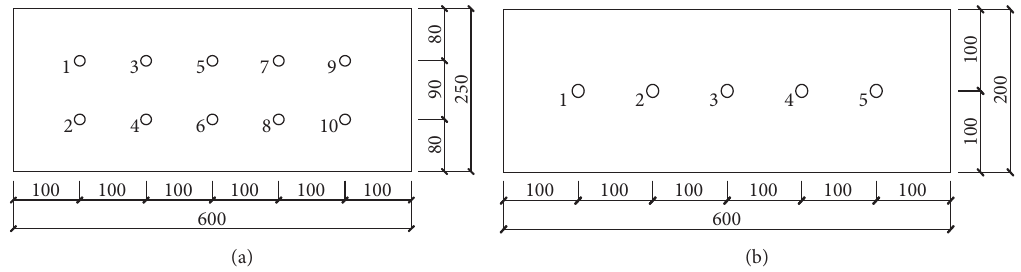
Figure 3: Layout drawing of block measuring points (unit: mm). (a) Main view. (b) Side view.